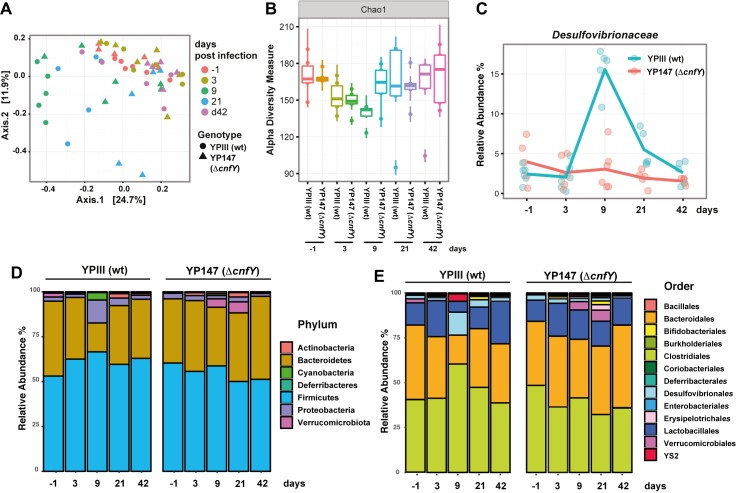
Gut microbiota in wildtype- and ΔcnfY mutant-infected mice.At indicated time points prior (-1) and post infection, feces was sampled from individual mice and tested for Y. pseudotuberculosis. The microbiota composition of persistently Yersinia-infected mice was analyzed by 16S rRNA gene sequencing. (A) Principal coordinates analysis (PCoA) was used to visualize β diversity globally and the bar plot displays the contribution of variables to the observed variance over all time points. (B) Analysis of α diversity using Chao1 index. (C) Relative abundance of the families Desulfovibrionaceae at indicated time points. Relative abundance of the bacteria grouped taxonomically by phyla (D) or microbial orders (E) from 5–6 mice.